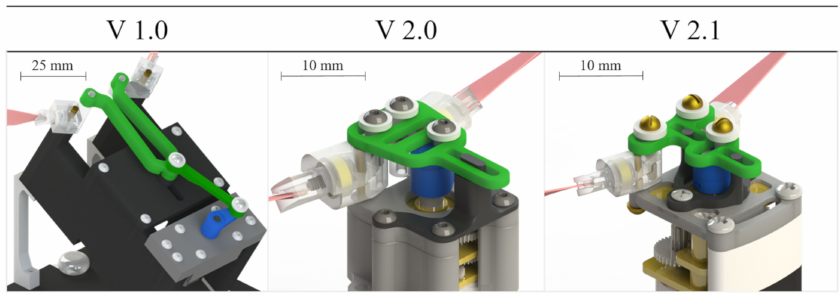
Figure 7. Progression of flapping-wing mechanism (FWM) development from left to right. In all versions shown, the forewings (pink) are attached to a wing adapter (clear) and shoulder joint (clear), which are driven by a linkage (green) between the shoulder joints and motor crank arm (blue). In versions 2.0 and 2.1, a ball bearing (yellow) is housed within the shoulder joint to allow minimal friction during spanwise rotation of the forewings. The shoulder joints rotate around small axles (brass) to achieve the oscillatory flapping motion. The motor is held in place via the motor casing, (gray) and stators (black) are used to guide the linkages through their desired motion.